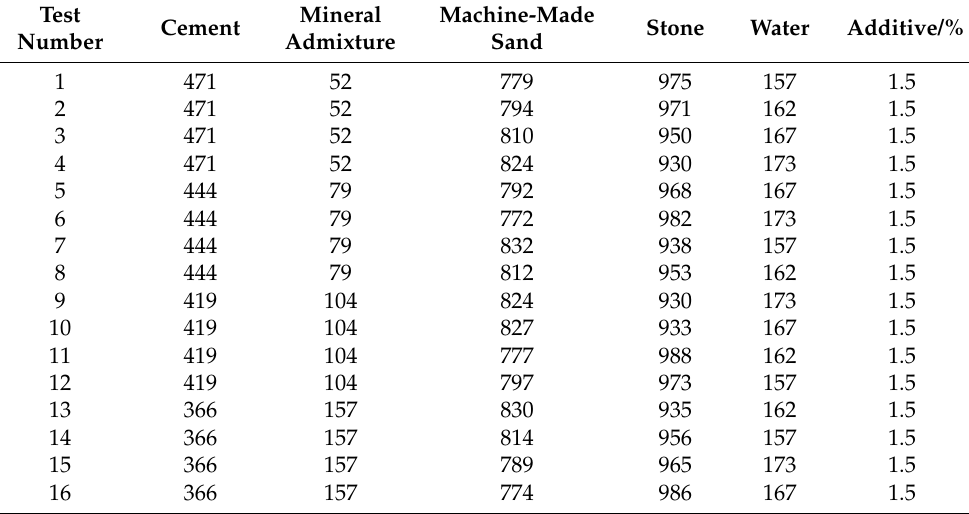
Table 4. Amount of each raw material for the test of machine-made sand concrete (kg/m 3 ).